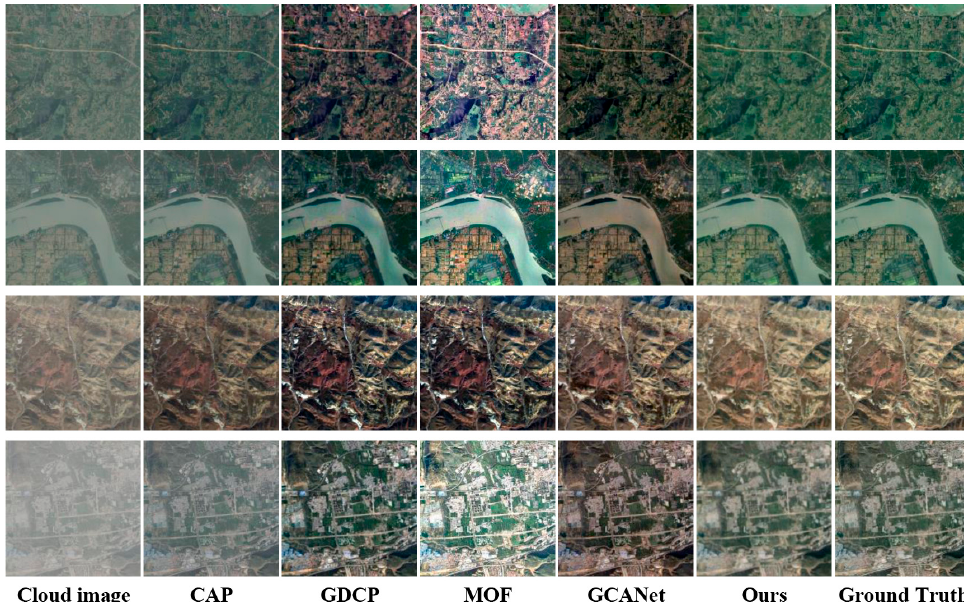
Figure 6. Results of the RICE-I dataset for image dehazing.